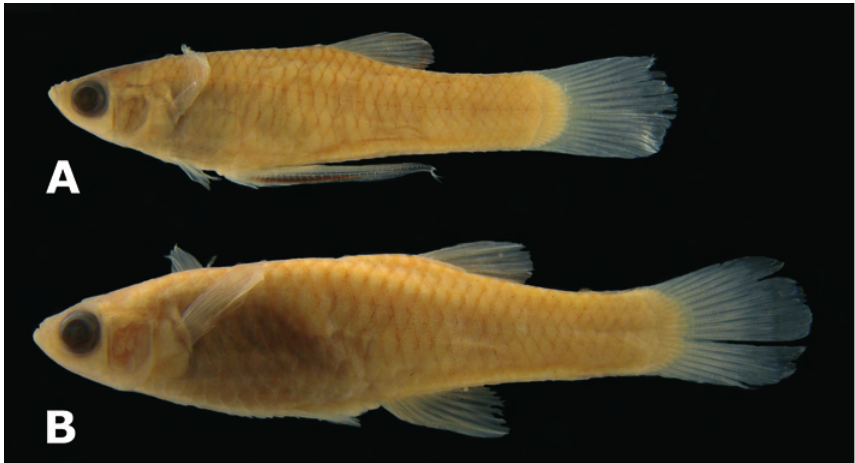
Fig. 19. Phalloceros aspilos . (A) Holotype, male, 23.6 mm SL, MNRJ 23607, rio Parati-Mirim, near km 202 of road BR 101, upstream Vila do Patrimônio; (B) paratype, female, MCP 30509, 33.7 mm SL, collected with the